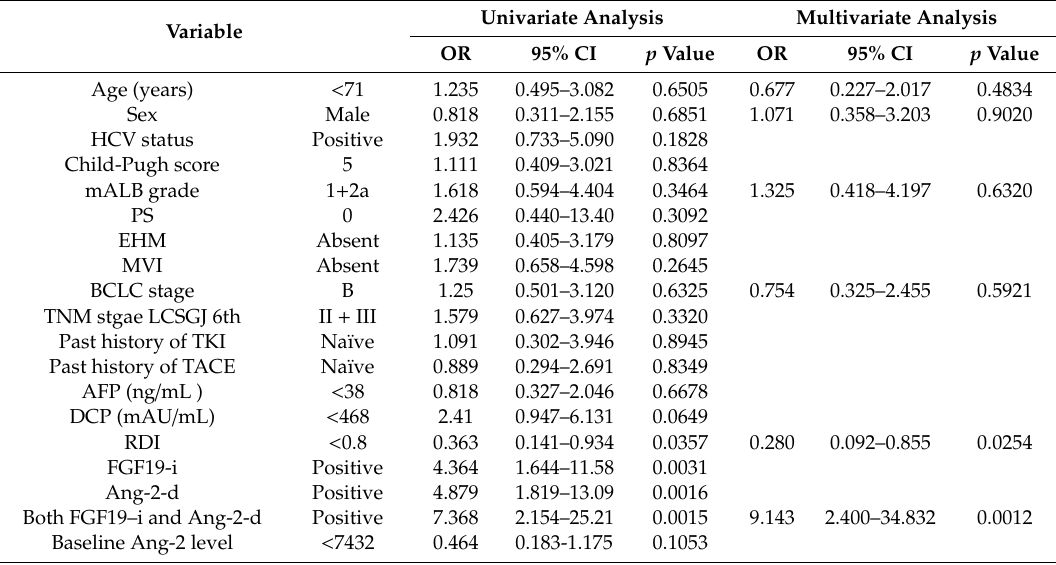
Table 2. Relationship between clinical factors and levels of biomarkers and objective response to